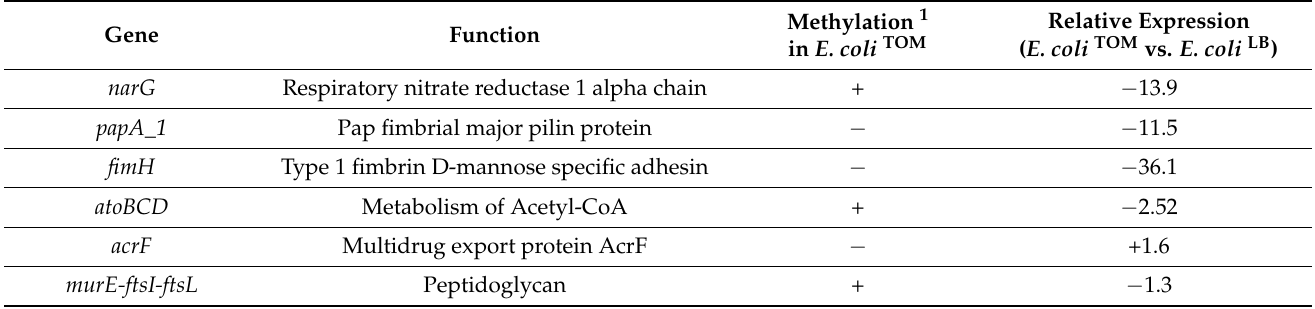
Table 1. Cytosine methylation state of E. coli TOM and relative gene expression in tomato pericarp.